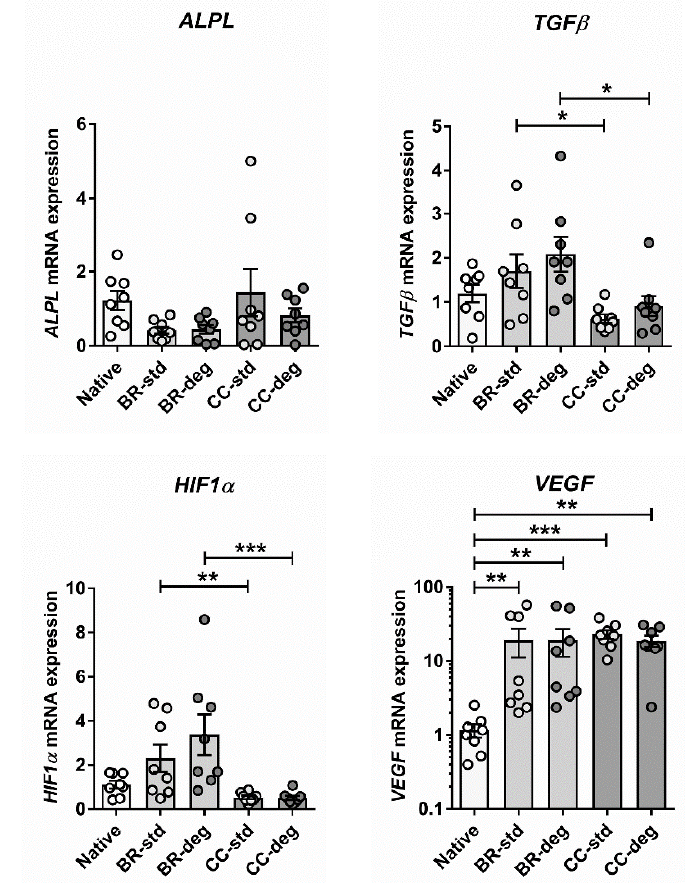
Figure 5. Characterization of the gene expression in aortic valve after bioreactor cultivation compared to static conditions. Valve bearing native aortic roots were cultivated in bioreactor with pulsatile flow (BR) or in a cell culture incubator (CC) for one week using standard medium (BR-std and CC-std) or medium with pro-degenerative conditions (BR-deg and CC-deg). Ovine aortic valve samples were examined using qRT-PCR with specific primers against the housekeeper RLP29, the pro-degenerative markers osteopontin ( OPN ), collagen type I ( COL1A1 ), alkaline phosphatase ( ALPL ), and TGF β as well as HIF1 α and VEGF . Values are shown as means and standard error of means, dots indicate eight biological replicates. For statistical analysis Mann–Whitney test was performed to compare standard and pro-degenerative conditions and Kruskal–Wallis test was used to compare native, BR and CC cultivation. Stars indicate significant differences in Dunn’s multiple comparison post-hoc test (* p < 0.05; ** p < 0.01; *** p < 0.001).